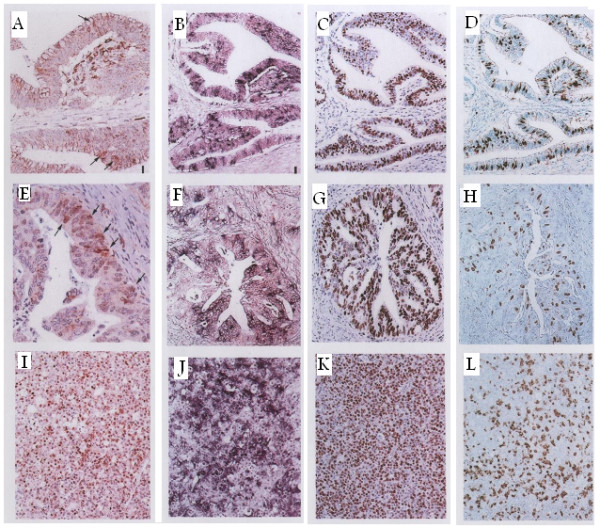
A case of well differentiated adenocarcinoma with positive immunostaining for: (a) cyclin D1, (b) histone H3 mRNA, (c) Ki-67, and (d) cyclin A. Another case of moderately differentiated denocarcinoma with positive immunostaining for: (e) cyclin D1, (f) histone H3 mRNA, (g) Ki-67, and (h) cyclin A. A case of poorly differentiated adenocarcinoma with diffuse staining for: (i) cyclin D1, (j) ISH of histone H3 mRNA, (k) Ki-67 and (l) cyclin A.